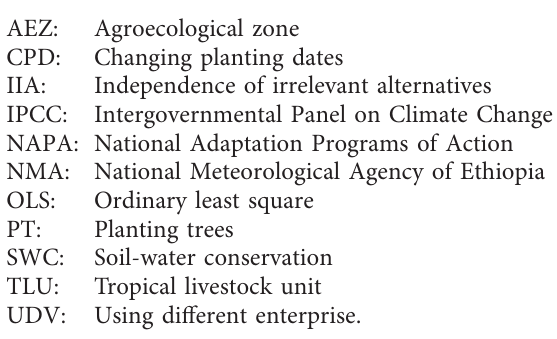
in the model. Appendix 1 Table 2: chi-square test of asso- ciation. Appendix 1 Table3: result of multinomial logistic regression using STATA 12. Appendix 1 Table 4: result of Poisson's regression using STATA 12 (for UDV). Appendix 1 Table 5: result of negative binomial regression using STATA 12 (CPD). Appendix 1 Table 6: result of Poisson's regression using STATA 12 (PT). Appendix 1 Table 7: